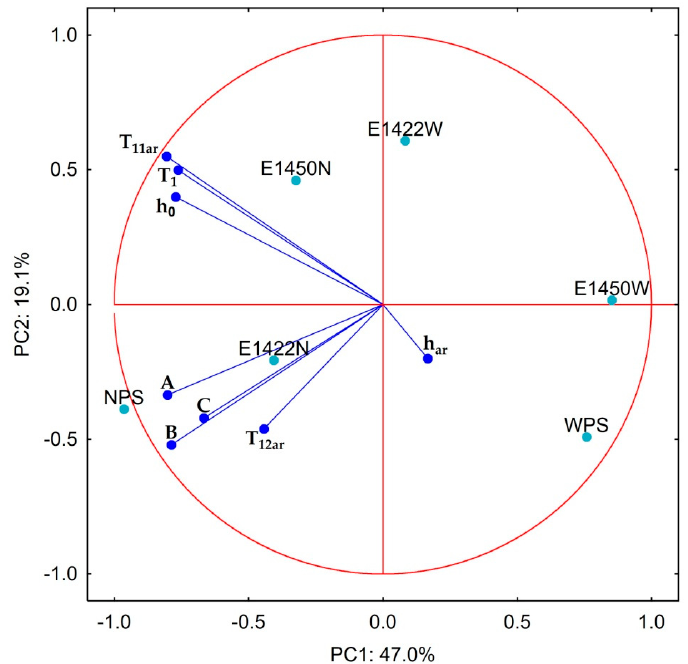
Figure 7. Principal component analysis biplot of the data characterizing the dependence of the equilibrium water activity as a function of hydration (A, B, C) and related to the hydration point at which all sorption sites of the aerogel are fully saturated (h 0 , h ar , T 1 , T 11ar , T1 2ar ). NPS: aerogels obtained from normal potato starch; WPS: from waxy starch; E 1422N, E 1422W, E 1450N and E 1450W: from E 1422 and E 1450 for normal and waxy starches, respectively.